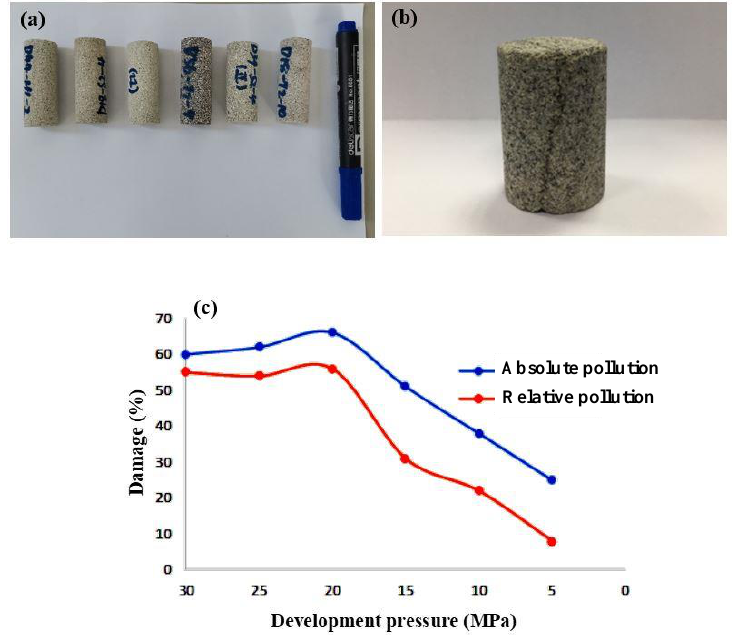
Figure 2. Core flooding samples. ( a ) Artificial core. ( b ) natural core. ( c ) Variation curve of solid solute pollution from fracturing water degree with formation pressure drop.